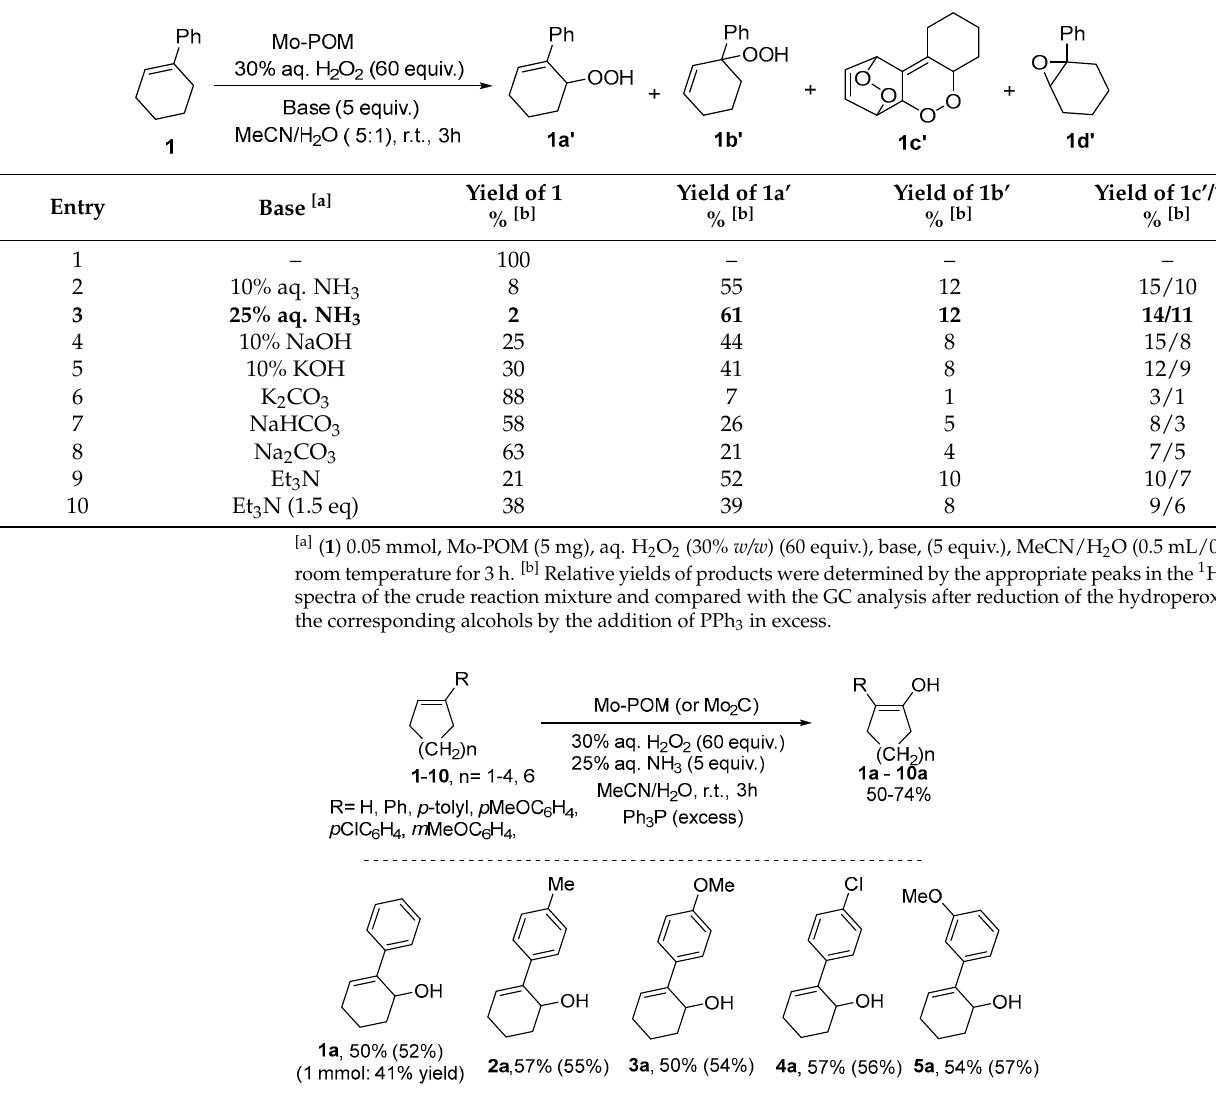
Table 2. Base screening in the oxygenation of 1 .